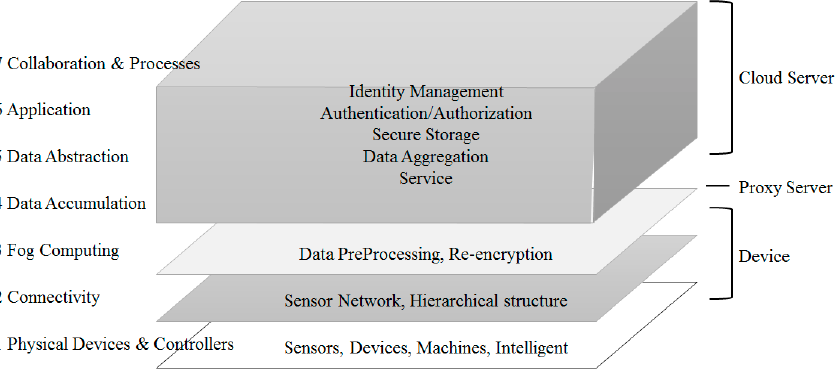
Figure 7. Role for Each Layer of the Proposed System.